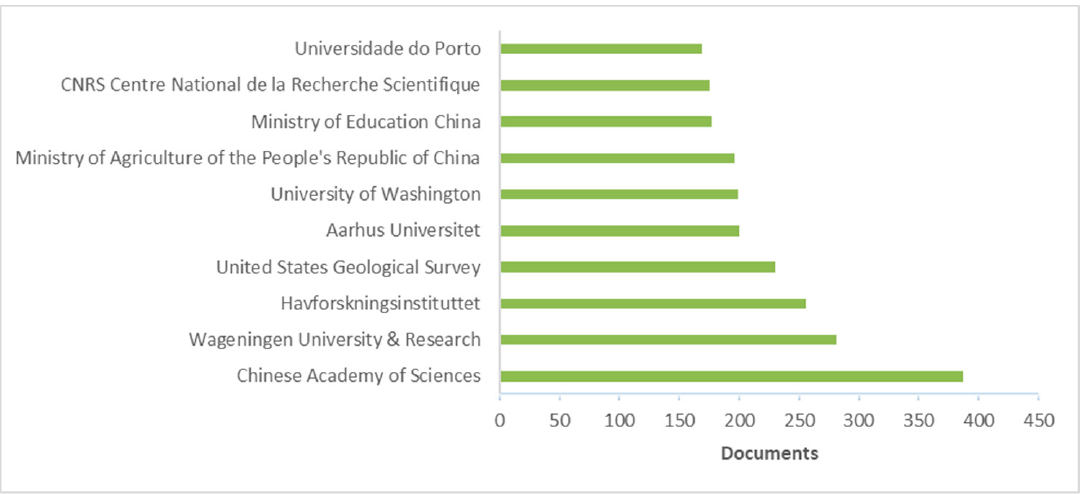
Figure 6. Most productive institutions. (Based on data from Scopus).